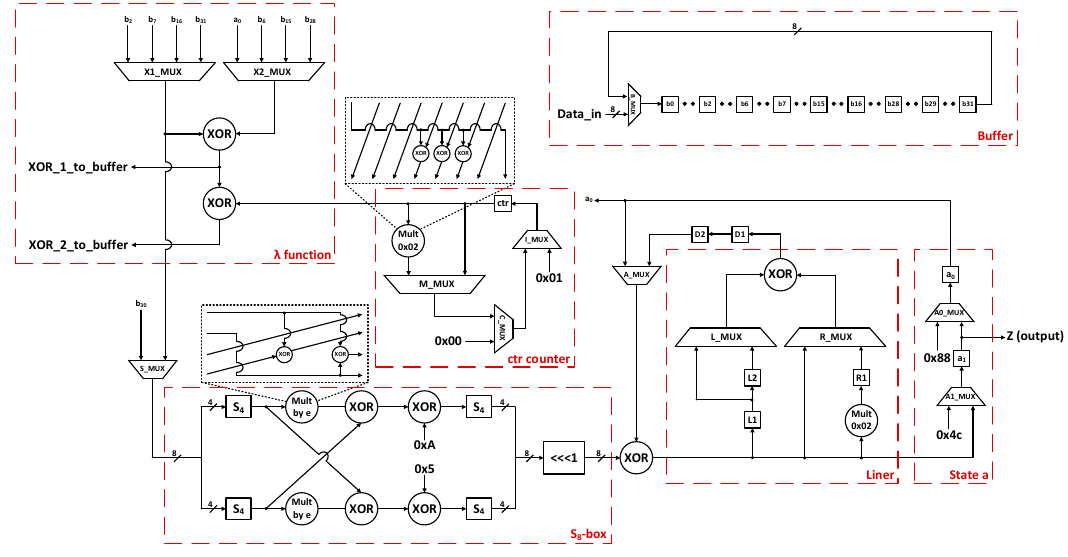
Figure 2. The proposed 8-bit architecture of Enocoro-128v2 stream cipher.